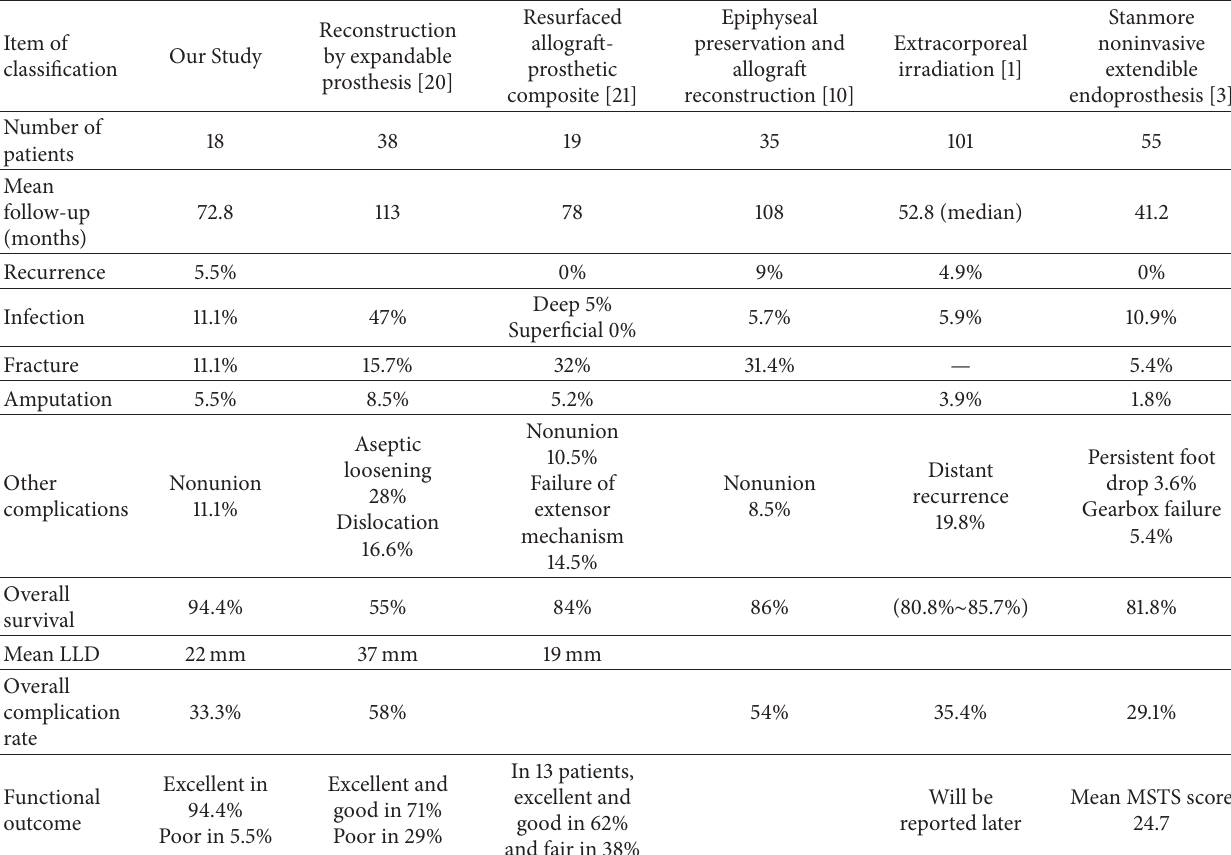
Table 2: Summary of different limb reconstruction methods used in